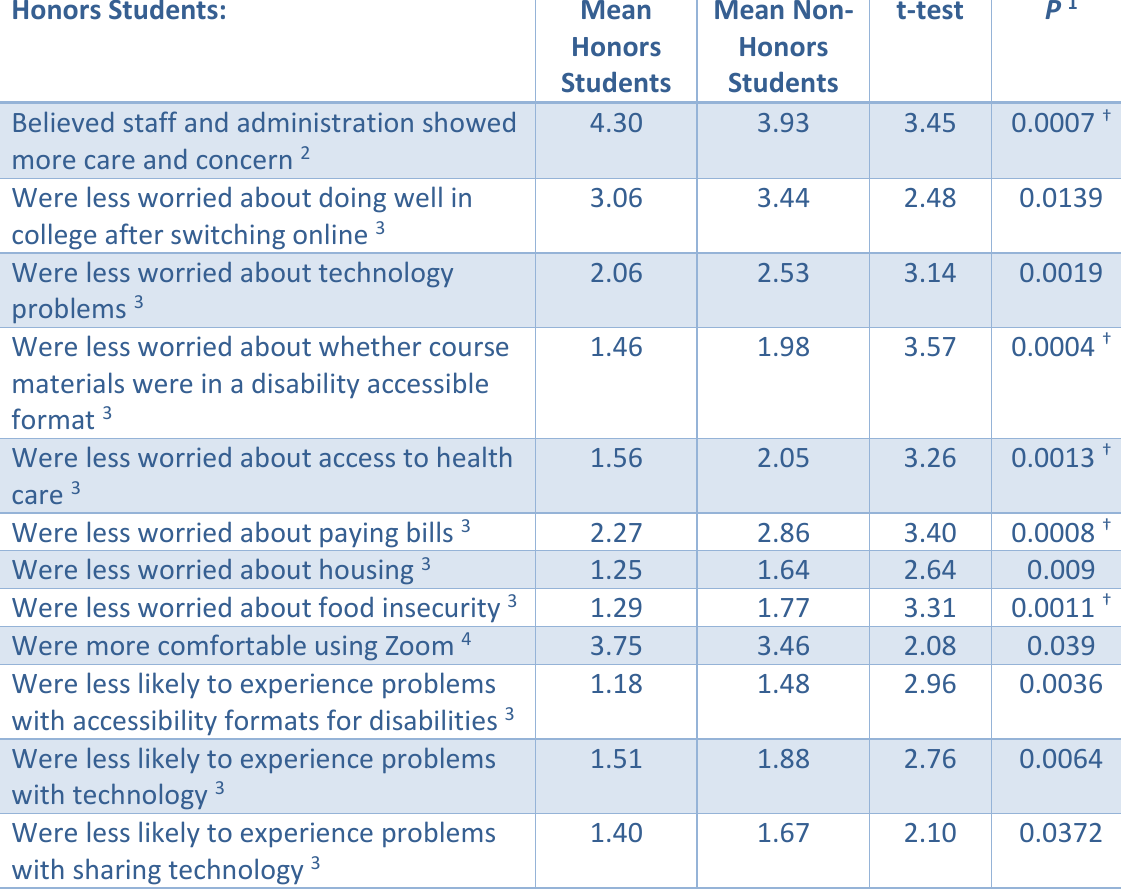
Table 1. Comparison of students who self-reported as 1) intending to graduate with Honors distinction (n=126) and 2) not intending to graduate with Honors distinction